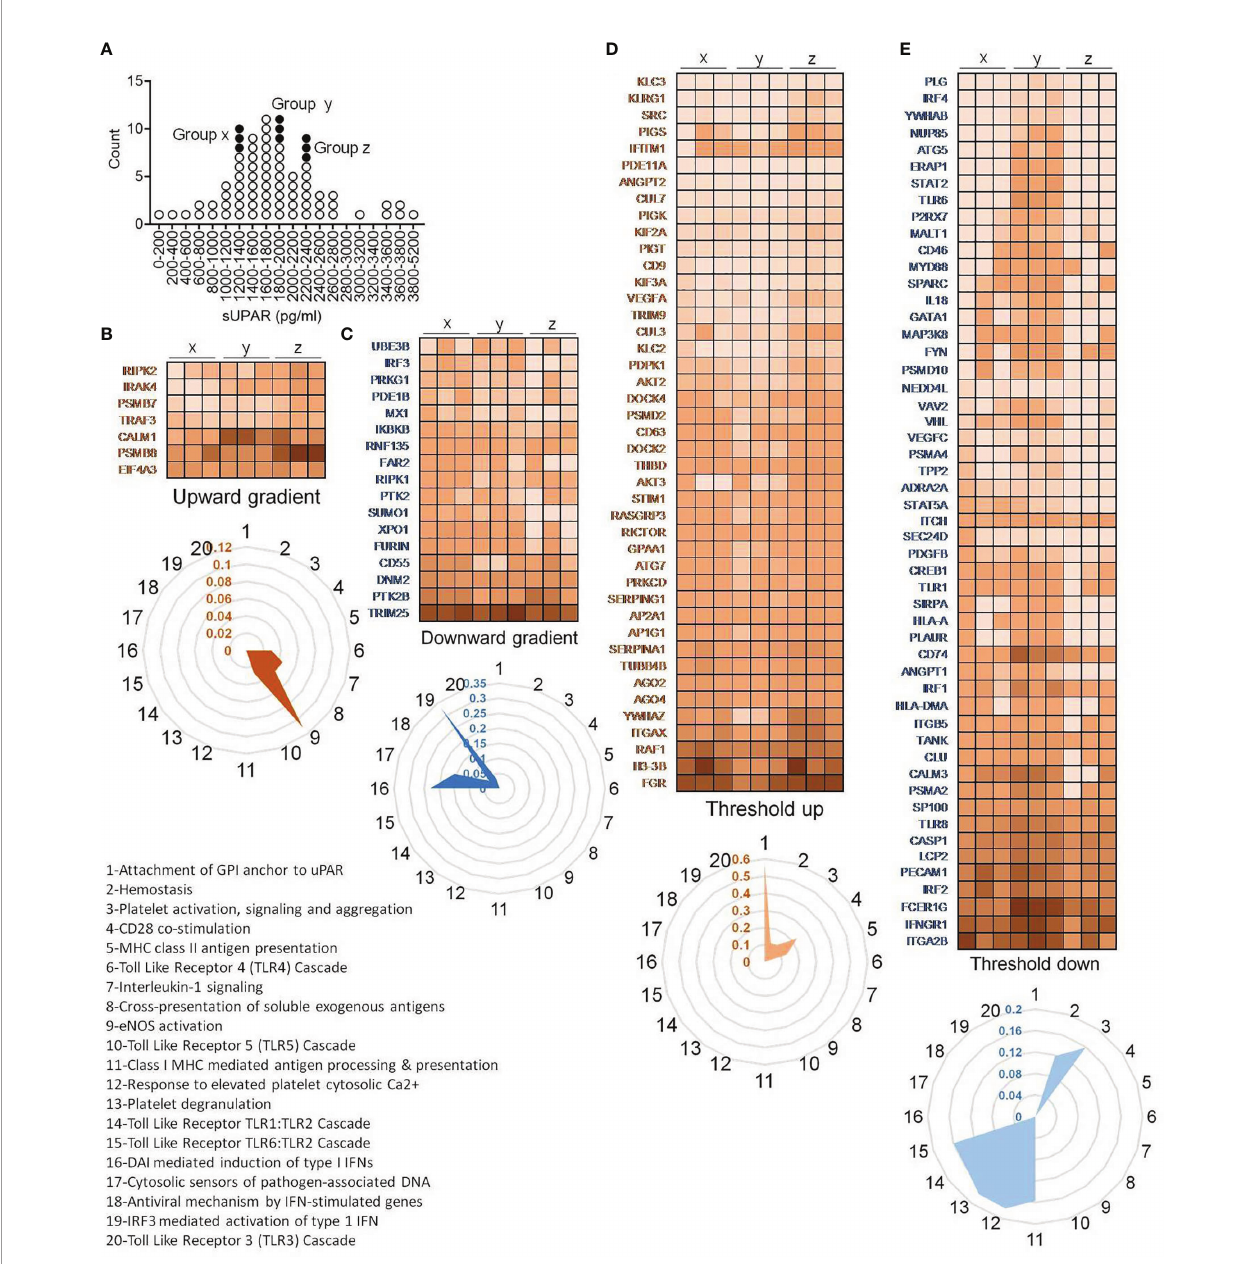
FIGURE 7 | Peripheral blood transcriptome analysis of representative patients. (A) Plot showing distribution of patients and their selection for RNA sequencing based on their plasma concentration of suPAR. Each circle represents an individual patient, and the fi lled circles represent the samples selected for RNA sequencing. Three patients each were randomly selected from three distinct ranges of plasma suPAR values (three each in groups “ x, ” “ y, ” and “ z, ” total of nine patients) as indicated. Group “ x ” patients had low suPAR plasma levels, the group “ y ” patients had suPAR levels just below the cutoff, and the group “ z ” patients had plasma suPAR levels higher than the cutoff. (B – E) Heatmaps depicting changes in TPM values of selected differentially expressed genes. The genes belong to one of the four indicated groups, categorized on the basis of pattern of changes in expression in patients with increasing plasma suPAR levels. The genes belonging to the threshold up/downregulated categories include genes which show signi fi cant up/downregulation in the group z patients as compared to the group y patients, while either showing insigni fi cant changes or signi fi cant changes in the opposite direction when comparing group y to group x. On the other hand, genes belonging to the gradient up/downregulated categories include those which show signi fi cant gradual/stepwise up/downregulation from group x to group z, through group y. The TPM value for each gene was calculated as the average of the TPM values of all the signi fi cant differentially expressed transcripts. Radar plots each depicting selected enriched pathways (for threshold/gradient up/downregulated genes) as determined from the Reactome database using the NetworkAnalyst software are shown below each heatmap (B – E) . The values represent the ratio of number of hits (genes) obtained in our dataset as compared to the total number of genes implicated in each pathway in the database. The pathways denoted as numbers (1 – 20) in the radar plots are